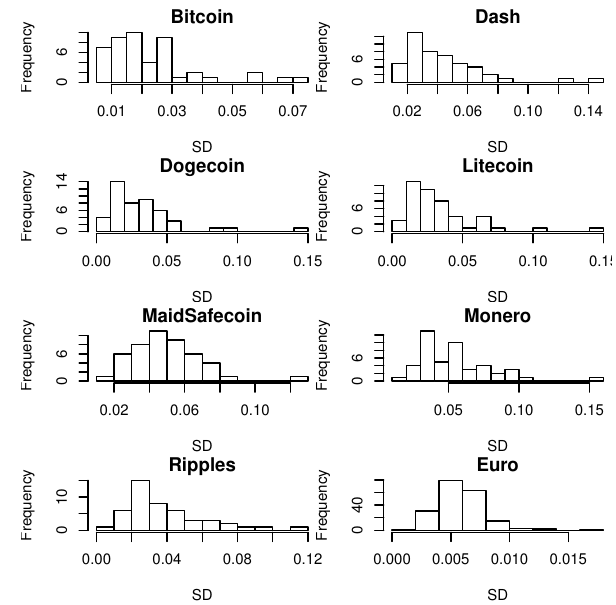
Figure 7. Histograms of standard deviations of daily log returns of the exchange rates of the seven cryptocurrencies over windows of width 20 days. Also shown is the histogram of standard deviations of daily log returns of the exchange rates of the Euro over windows of width 20